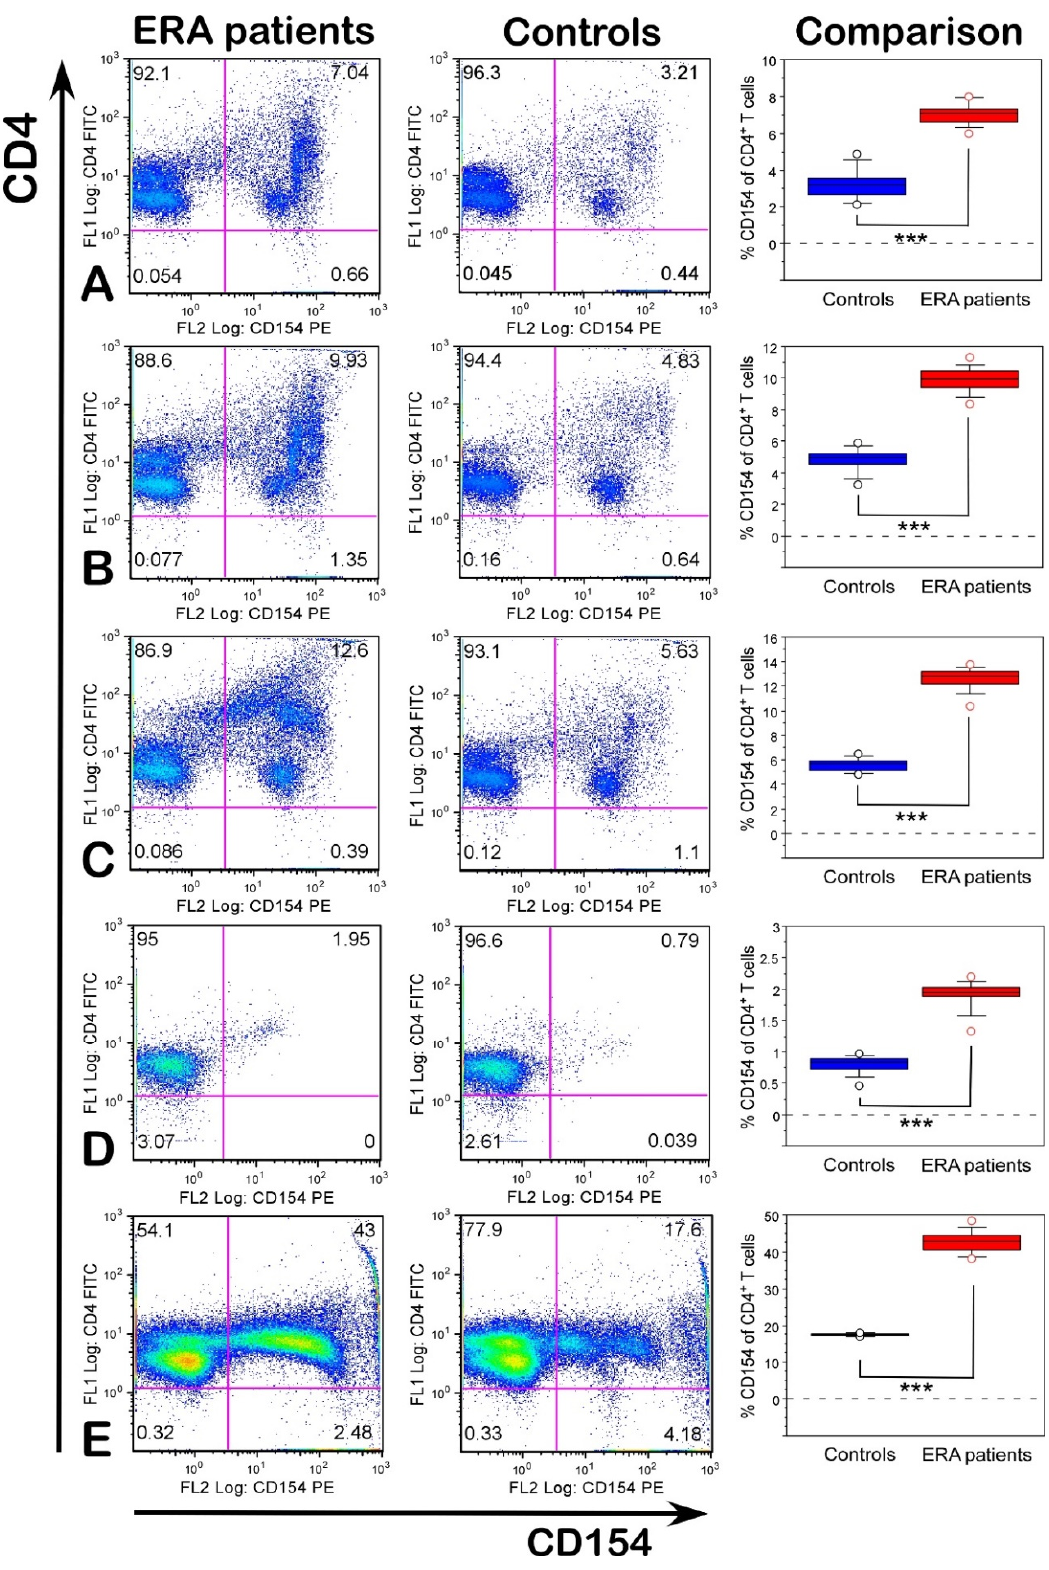
Figure 3. Expression levels of CD154 (% measured by flow cytometry) on CD4 + T cells in ERA patients and healthy individuals after in vitro stimulation with CII259-273 ( A ), L-ASNase67-81 ( B ), Gal264-CII259-273 ( C ), without stimulation ( D ), and with PHA-L ( E ). In the last column, (comparison) data are presented as means ± SE. *** p ≤ 0.001. Flow cytometry analyses were performed using a Cytomics FC500 flow cytometer.